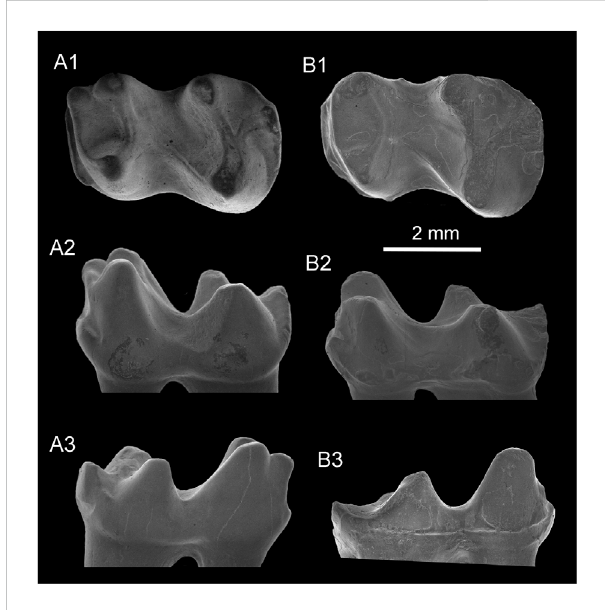
The lower molars of Obotherium sp.1 (A) and Obotherium sp. 2 (B) . (A) left m1/2 (IVPP V 31735); (B) left m1/2 (V 31736): (A1 – B1) , occlusal view; (A2 – B2) , buccal view; (A3 – B3) , lingual